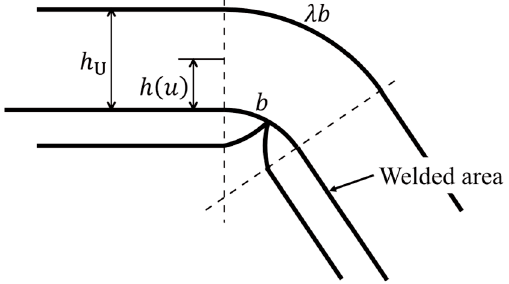
4 of 14 Figure 3. Required elongation of upper film.